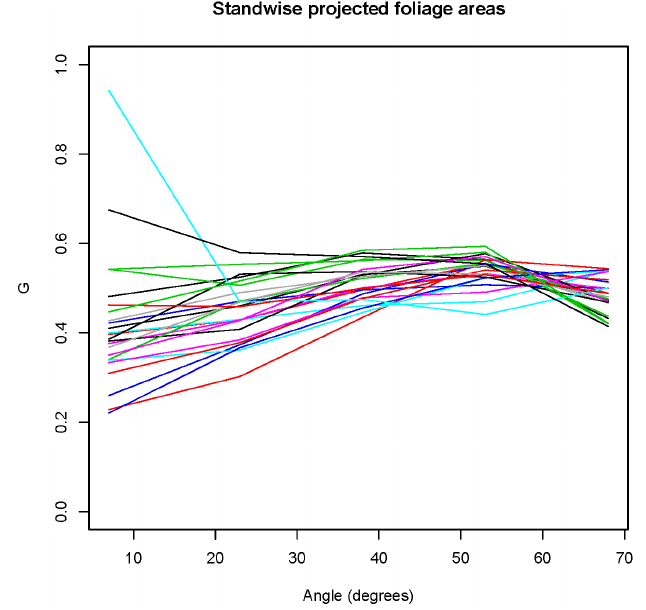
Figure 9. Standwise values of the mean projection of unit foliage area (G) as a function of sun zenith angle, calculated from ground based hemispherical photos of